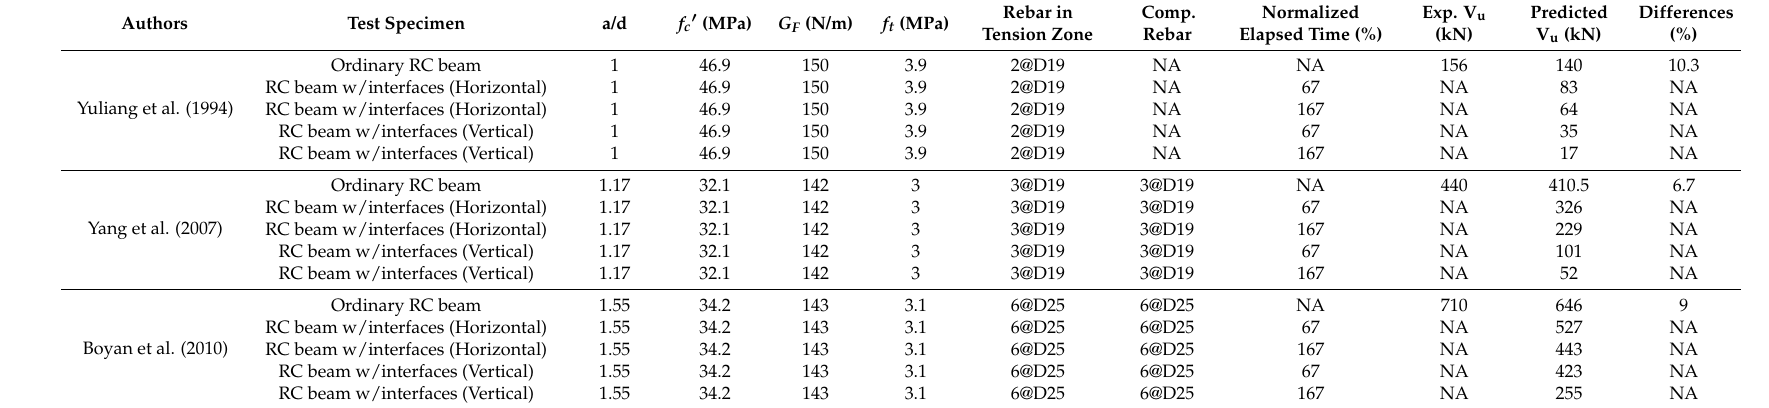
Table 5. Obtained results for predicting shear strength of normal and layered RC